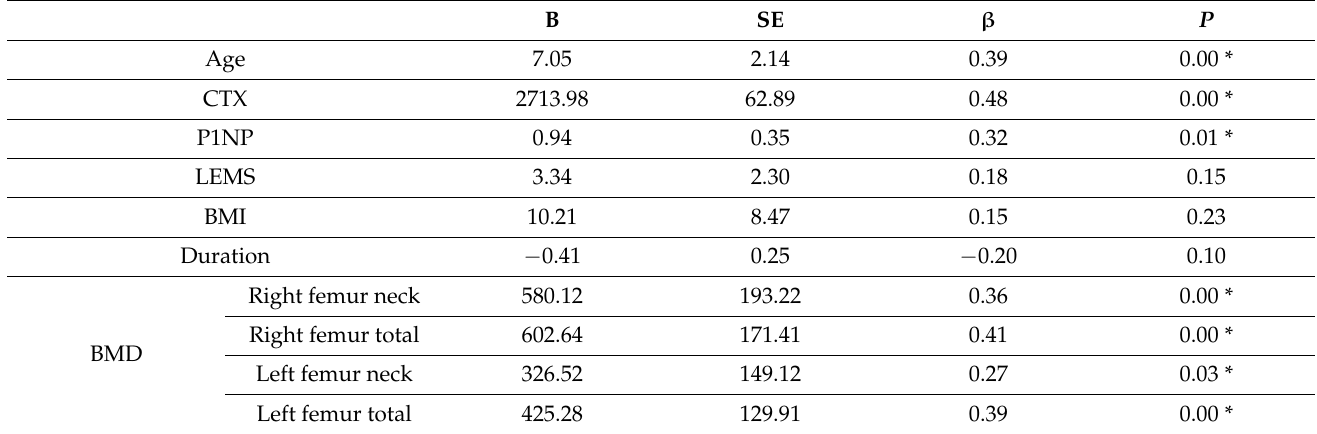
Table 4. Univariate regression analysis of clinical factors according to sclerostin serum concentration.